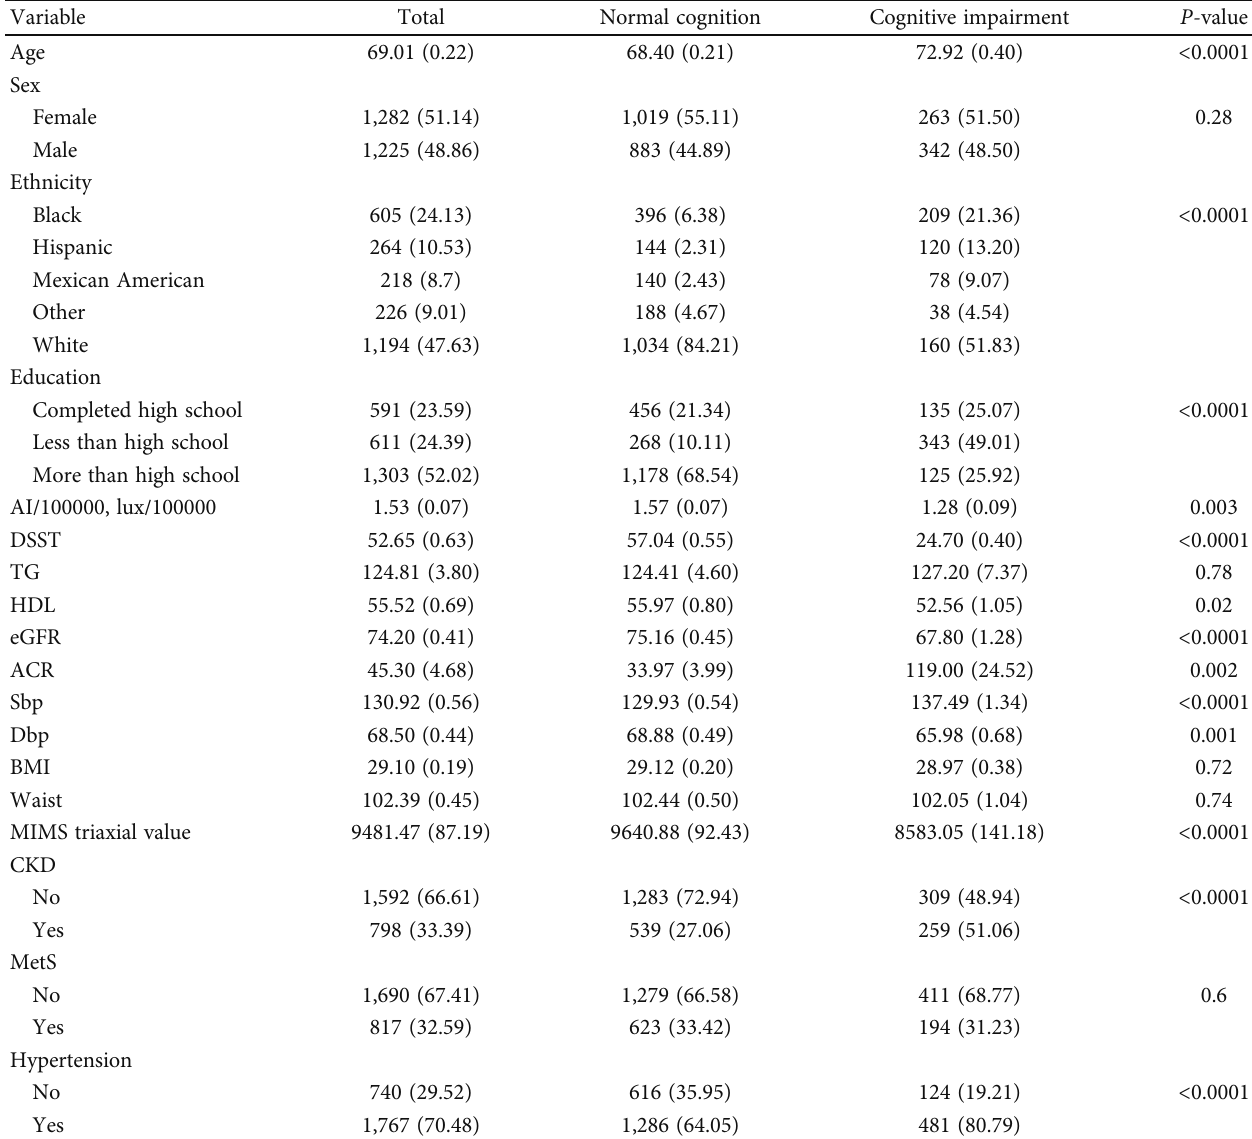
Table 1: Characteristics of the study population from NHANES 2011 – 2014 ( n = 2,507